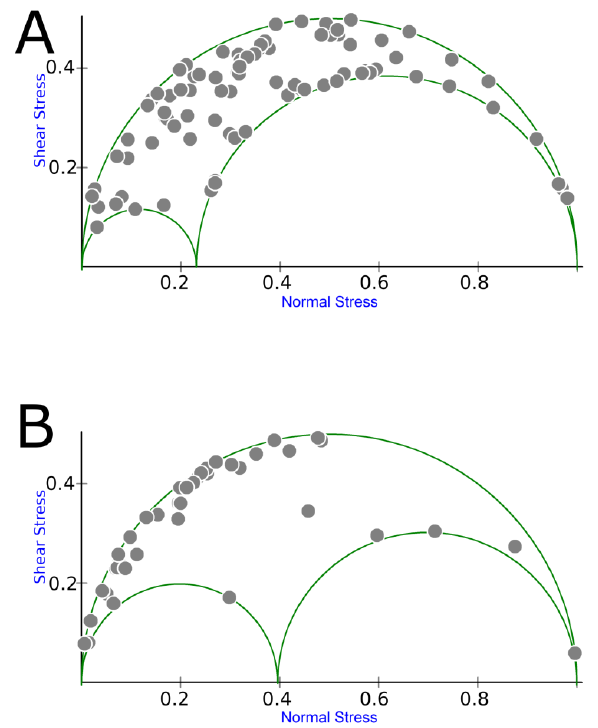
Figure 12. Mohr circles ( A ) and ( B ) for inversions A and B with the maximum resolved stresses in the fault plane shown in grey. This figure demonstrates that inversion B is a better-oriented dataset to perform a stress inversion on.